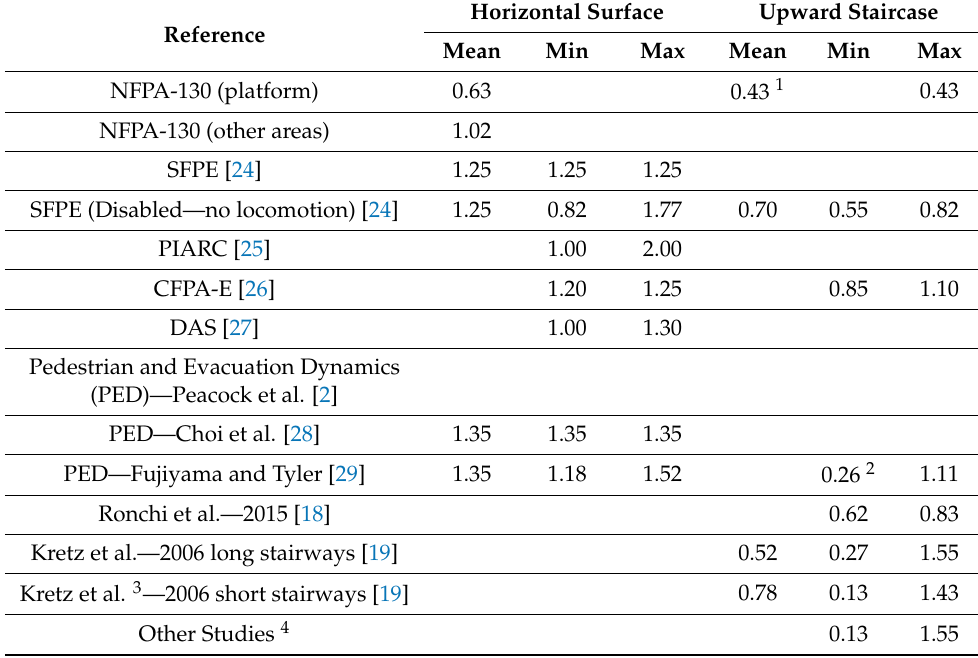
Table 1. Walking speed (m/s) during unimpeded travelling.